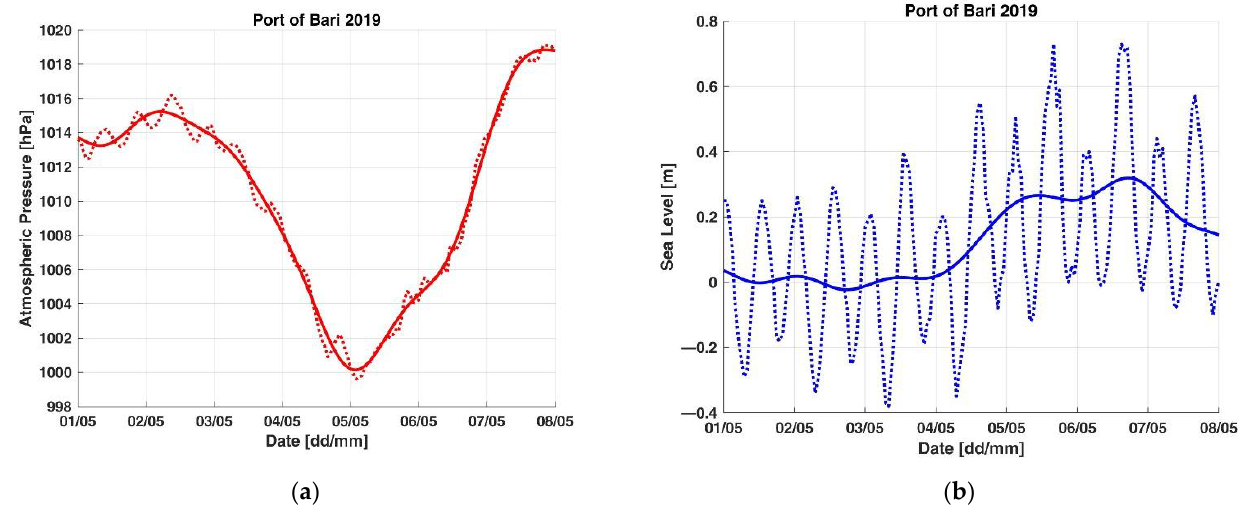
Figure A19. Low-frequency components of meteo-mareographic parameters acquired by ISPRA’s monitoring station in the port of Bari from 1 to 8 May 2019: ( a ) atmospheric pressure; ( b ) sea level.